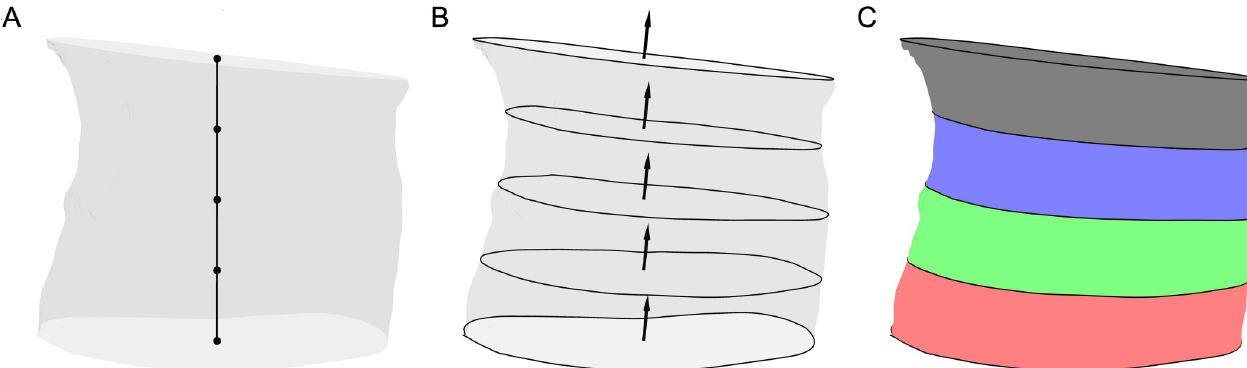
Fig 1. Division of carpal tunnel into quartiles to calculate volume distribution. Panel A shows points at 0%, 25%, 50%, 75%, and 100% of the distance along the vector between the centroids of the proximal and distal ends of a representative carpal tunnel in neutral posture. Panel B shows the planes which divide the tunnel oriented as a weighted average of the proximal and distal boundary normal vectors. Panel C shows the division of the tunnel volume into quartiles, where Q1(proximal) is red, Q2 is green, Q3 is blue, and Q4 (distal) is black.